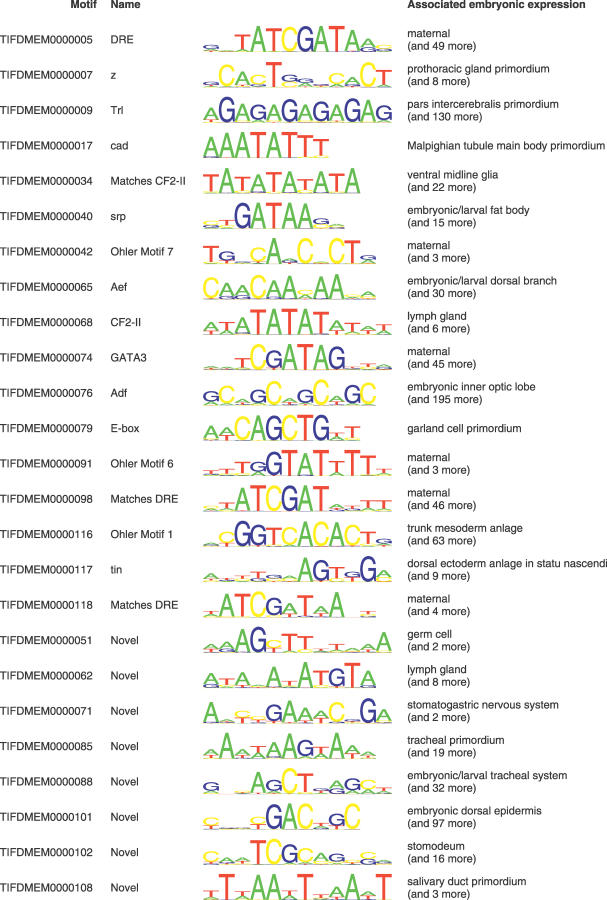
Motifs with Significant Correlations to Embryonic Expression PatternsA top-scoring ImaGO term is shown for each motif.